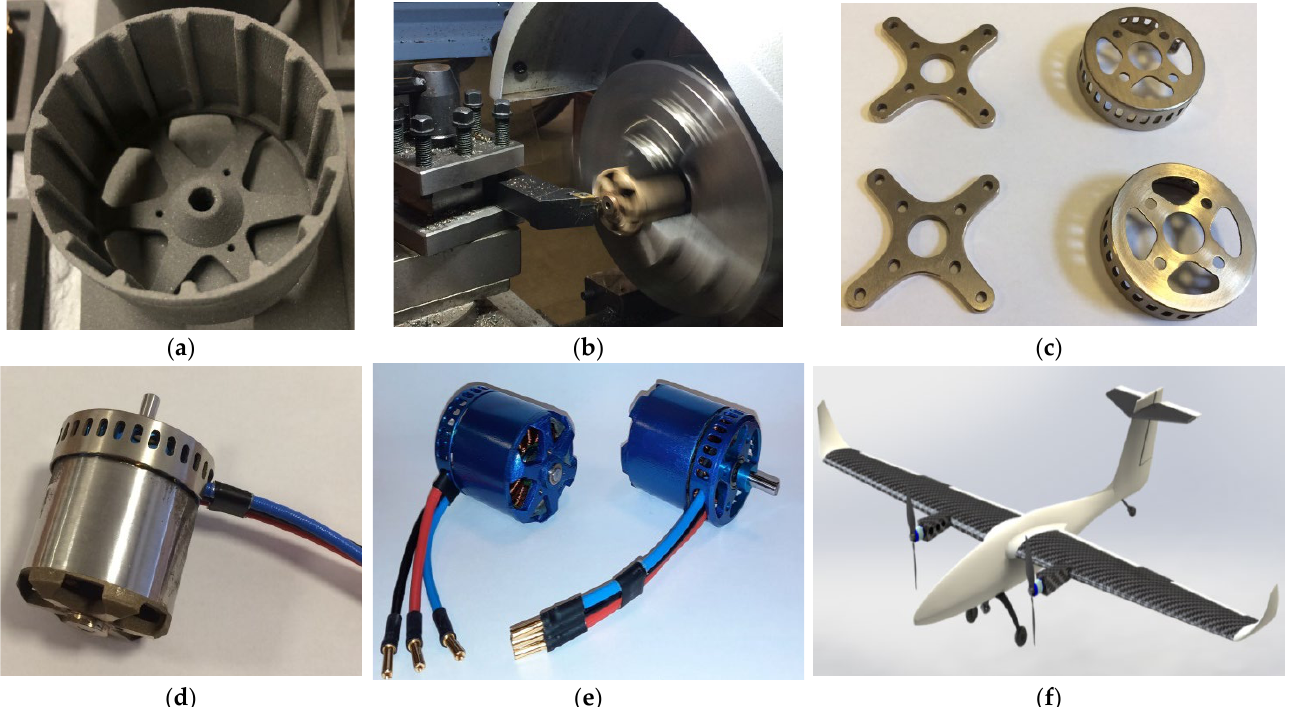
Figure 4. Assembling BLDC motor components: ( a ) rotor fitted with spacer; ( b ) rotor turning; ( c ) motor mount and left housing; ( d ) assembled motor; ( e ) electric motor prepared for testing; ( f ) the UAV aircraft on which the BLDC motors will be mounted.